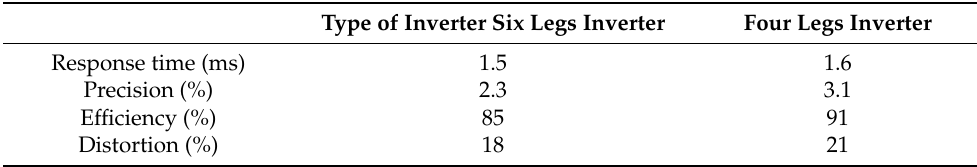
Table 3. Comparative chart of the two techniques (in nominal conditions).